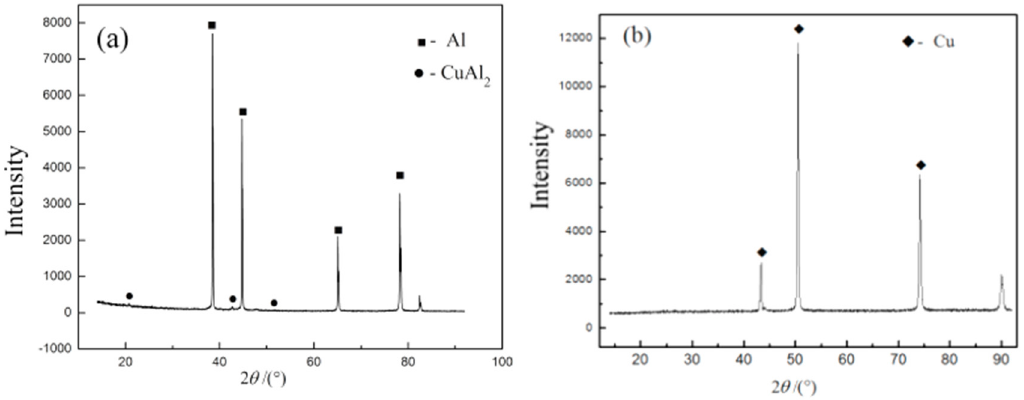
Figure 6. XRD patterns of bonding interface in Cu/Al composite panels.